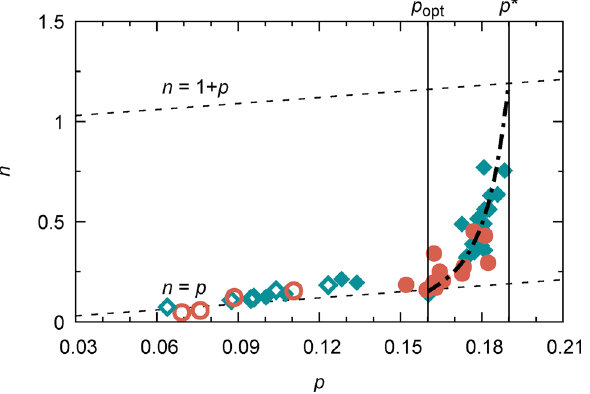
Figure 3. Evolution of the charge carrier density with doping. YBCO normal state charge carrier density per n H V CuO 2 -plane, n , is drawn as a function of doping p . The charge carrier density is given by n 2 at 100 K. The = doping p is obtained for optimally and overdoped samples (full symbols) via HR-XRD measurements of the c -parameter and for underdoped films (open symbols) from the parabolic doping dependence of T c . The vertical p , corresponding to a Fermi-surface with lines indicate optimally and critical doping. Below p opt we find n = small hole and/or electron pockets in the underdoped regime. For p > p ∗ a large, cylindrical FS is expected in 1 p . A transition between a small and a large Fermi-surface occurs the metallic overdoped regime, with n = + above